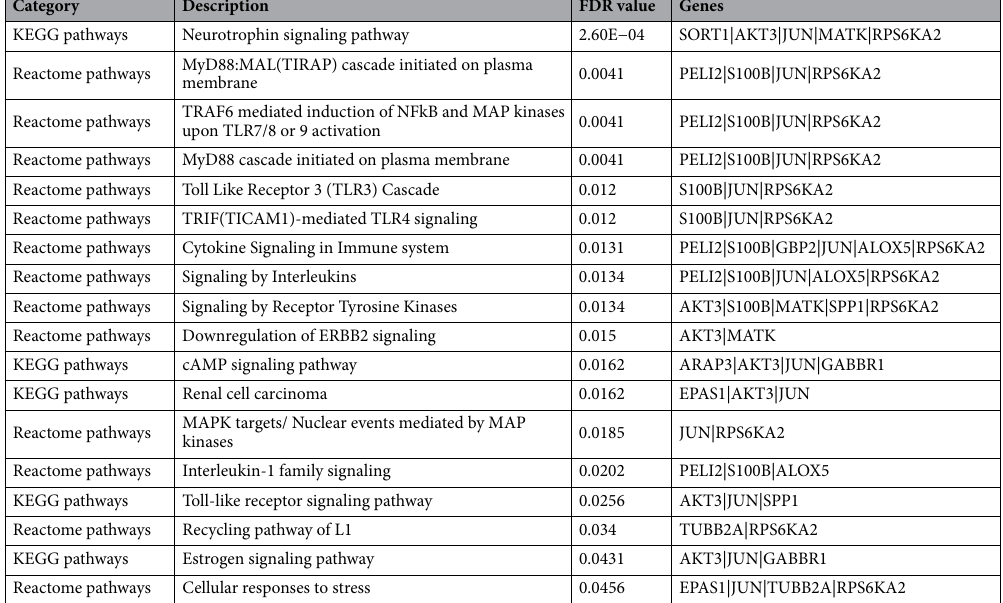
Table 5. Pathways and genes identified using StringApp (related to Fig. 7b). FDR false discovery